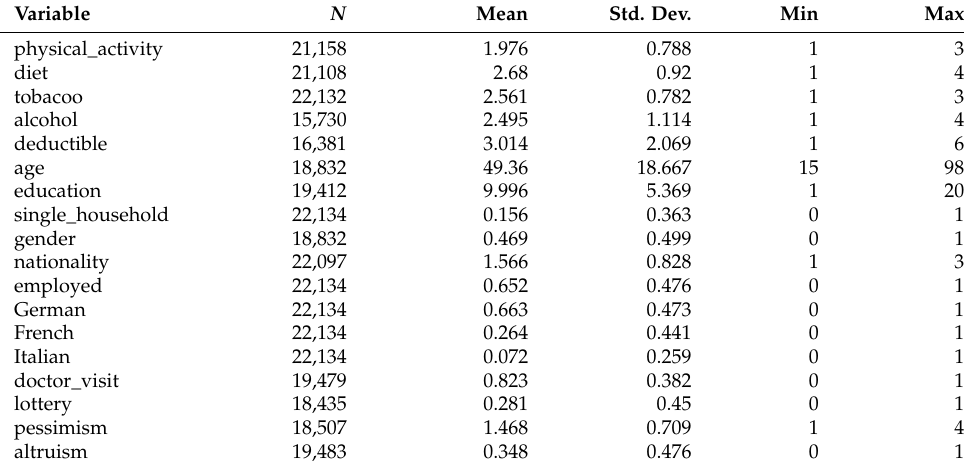
Table 1. Descriptive statistics.